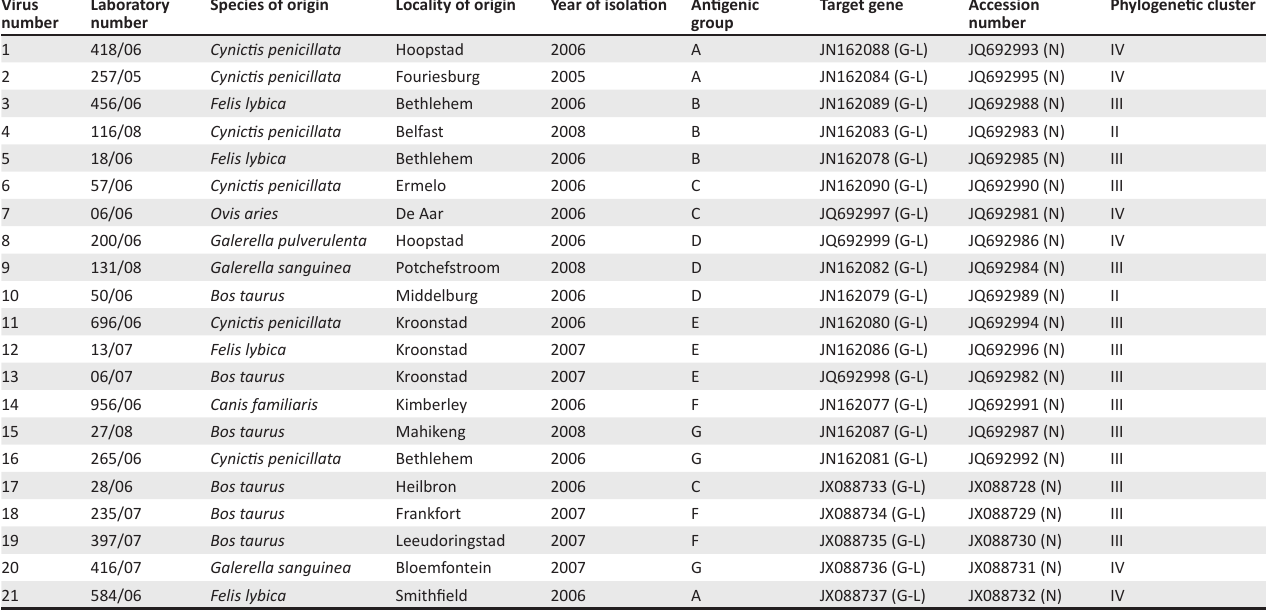
TABLE 2: Representative mongoose rabies variants from each antigenic group that were included in phylogenetic analyses. Virus Laboratory number number